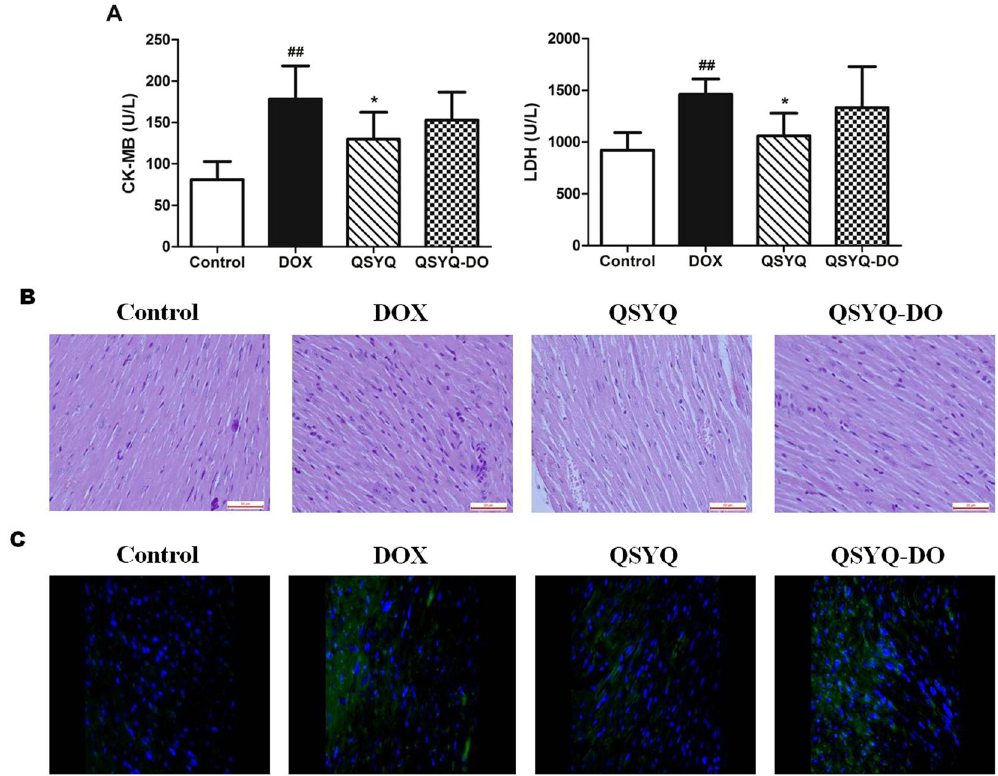
Figure 6. Effects of QSYQ and QSYQ-DO on cardiac enzyme release and myocardial histology. (A) CK-MB and LDH release in serum of DOX-treated mice, (B) Representative images showing H&E staining of heart sections (400 × magnification), and (C) Representative photomicrographs of TUNEL staining images. Total nuclei were labeled with DAPI (blue) and apoptotic nuclei were detected by TUNEL staining (green). One of 8 similar images was shown. All scale bars are 50 μ m. Data are expressed as mean ± SD, n = 8. ## p < 0.01 vs . Control group. * p < 0.05 vs . DOX